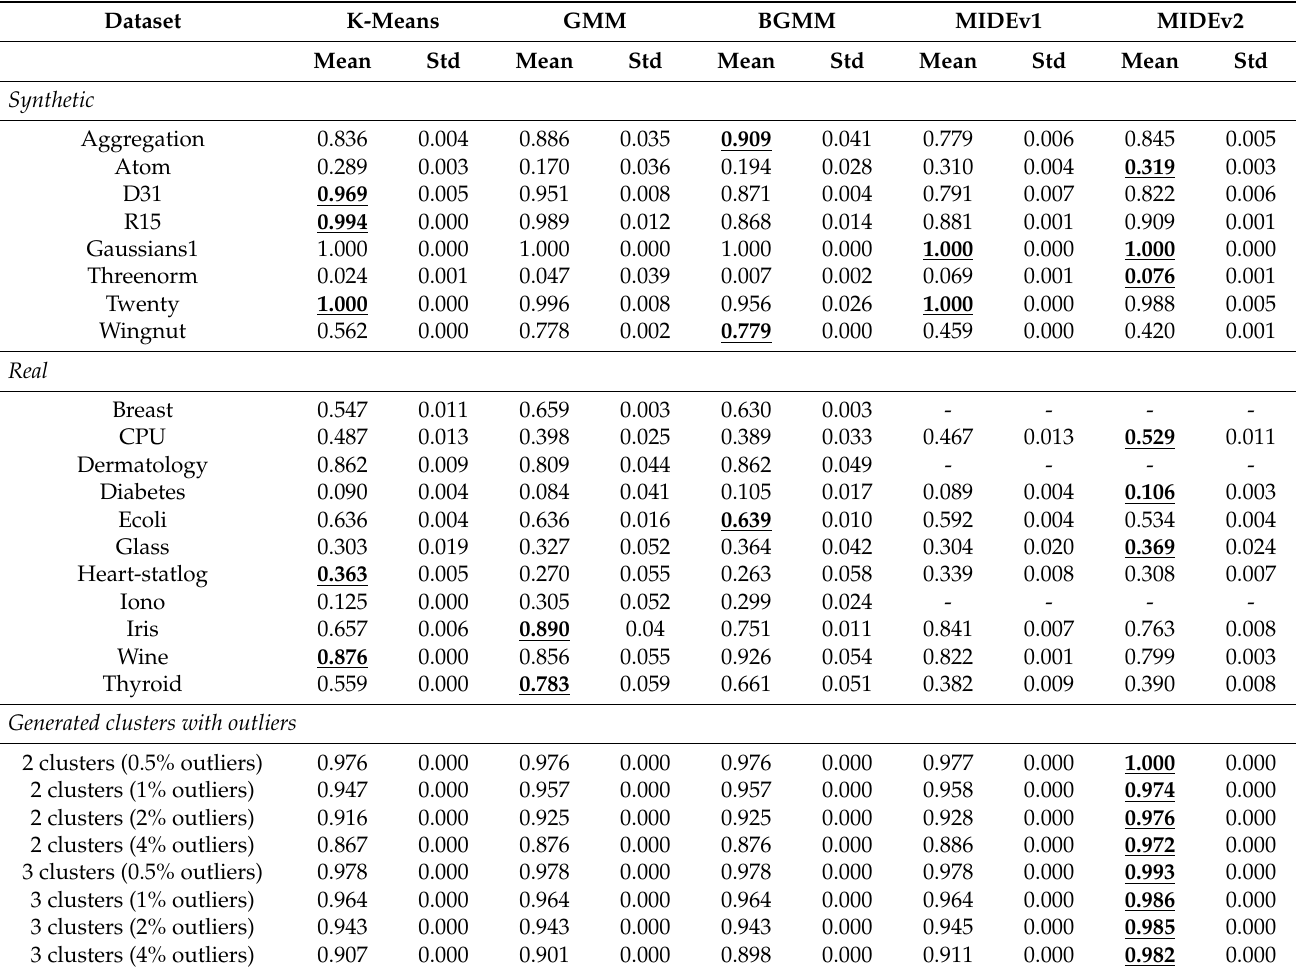
Table A1. Comparative table of different models (means and standard deviation) based on Normal- ized Mutual Information (NMI) for 10,000